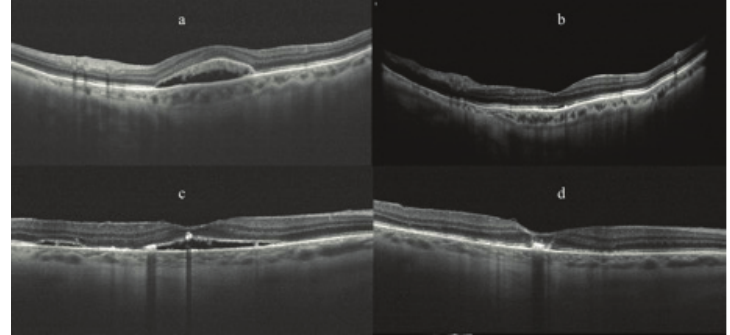
Figure 1. Cases 1 and 2: OCT before SML treatment showed an optically empty macular space between RPE and neuroepithelium with granular deposits adhering to the outer photoreceptor segments (a & c) . After photostimulation, PSF was undetectable by OCT and granular deposits were unchanged (b & d).